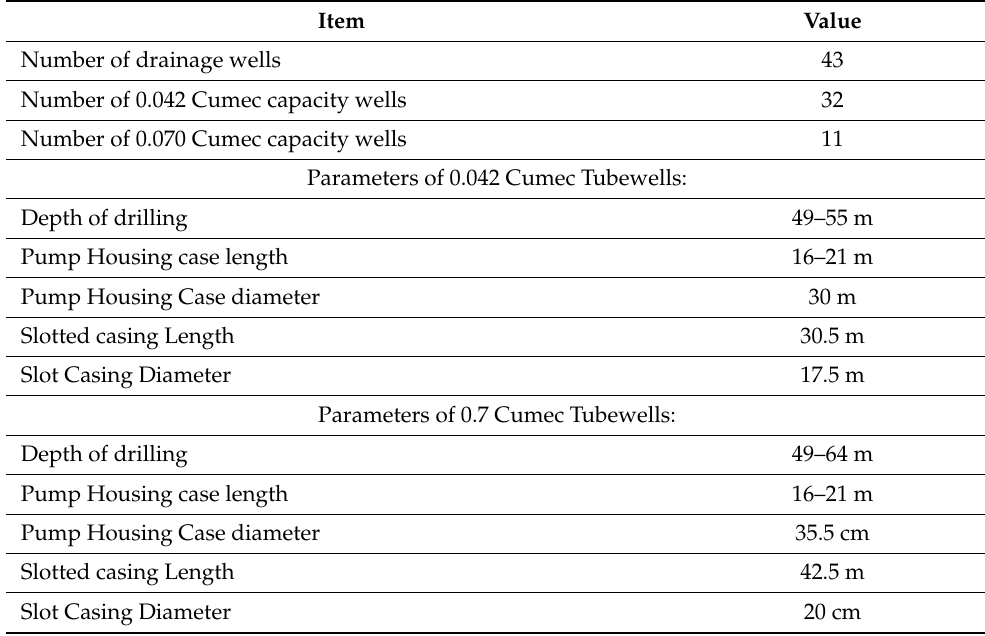
Table 2. Data on 43 Drainage Tubewells (Source: [27]).